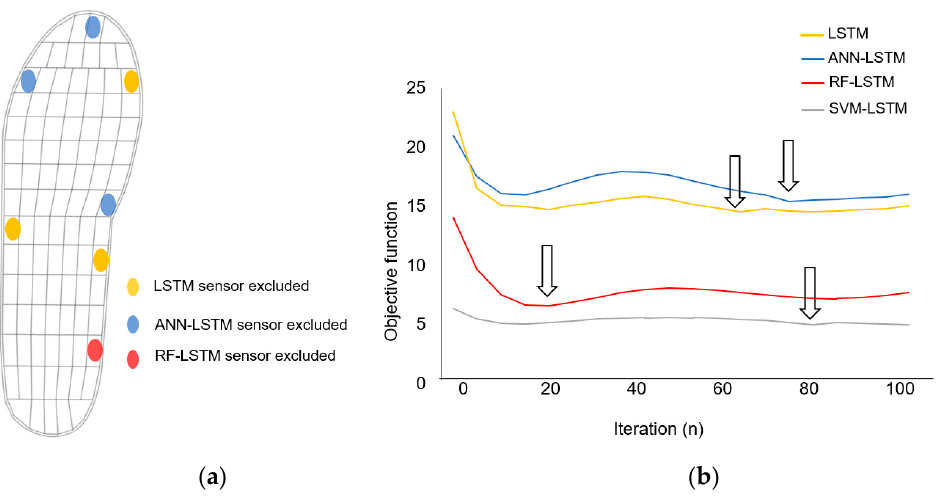
Figure 2. ( a ) Selected optimal sensor location; ( b ) The progress of optimization using Bayesian optimization showing the objective function value for selecting optimal input feature.